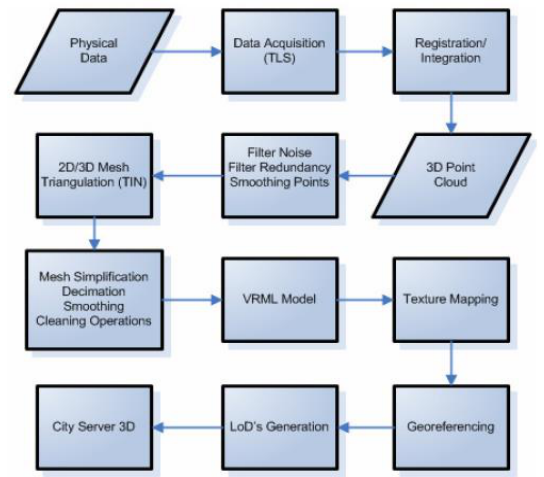
Figure 3. Methodology (Adopted from Mumtaz, 2008)